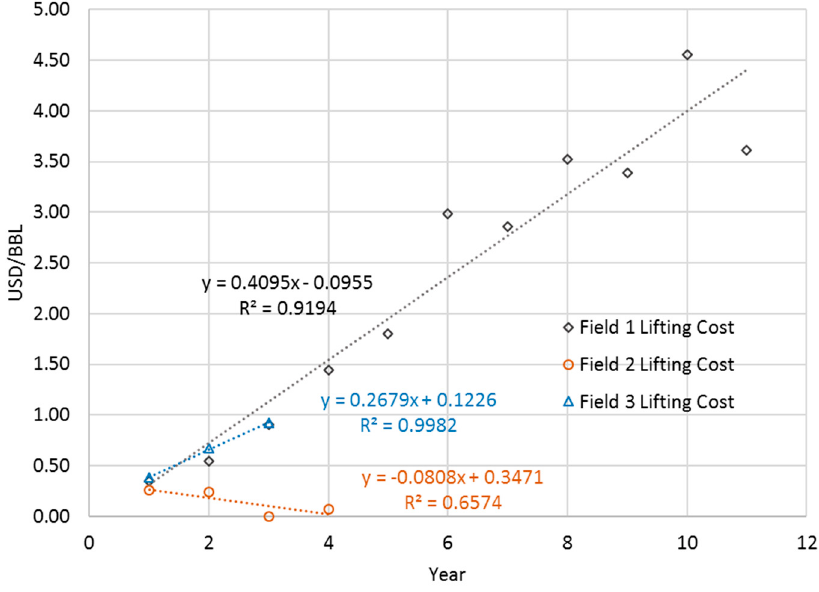
Figure 9. Comparison of lifting costs between Fields 1, 2, and 3.